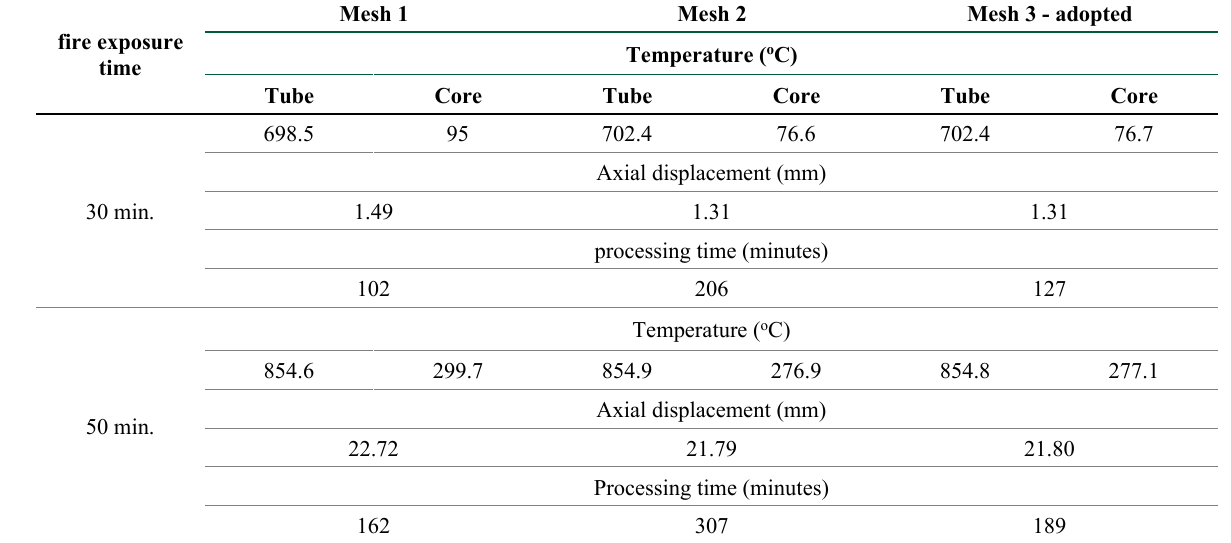
Table 1. Mesh sensitivity study (specimen -